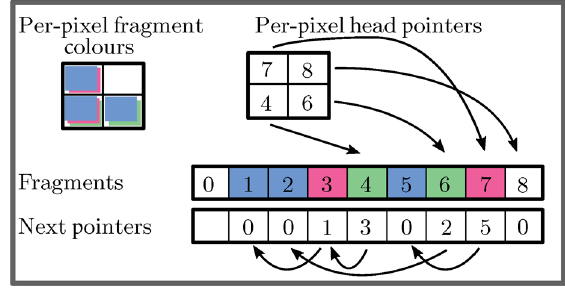
Fig. 2 Per-pixel blue/red/green, blue/green, and blue/red fragment colours as linked lists.